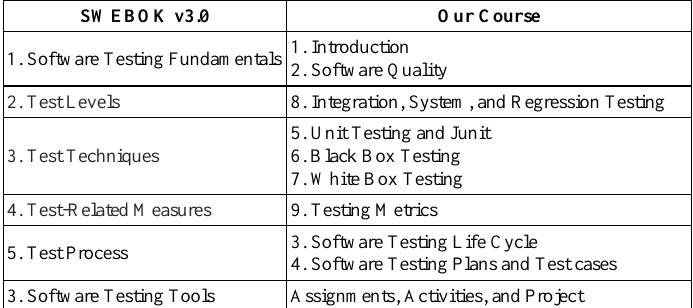
Table 2. Mapping course topics to SWEBOK